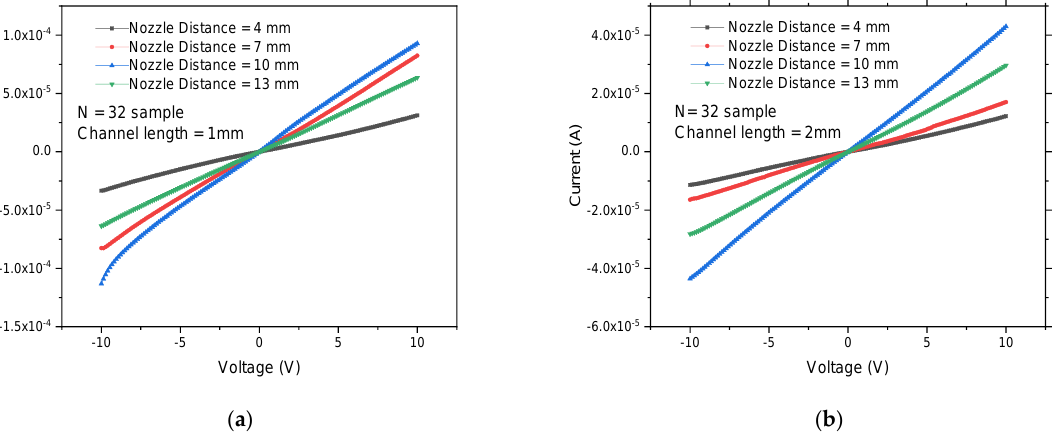
Figure 3. IV measurements for studying substrate – nozzle distances using DIPS SWCNTs sample at different channel length; ( a ) 1 mm; ( b ) 2 mm.